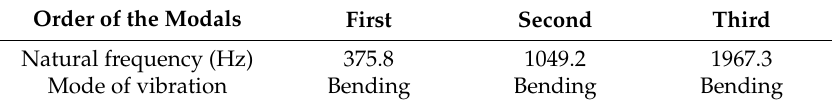
Table 4. Natural frequency of pipeline with ACLD patches.